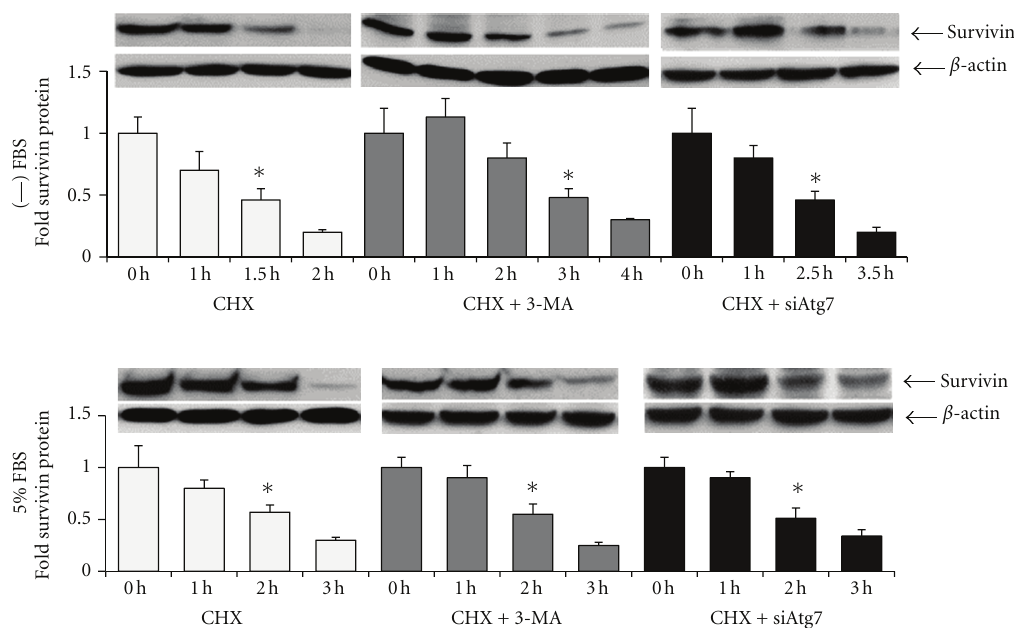
Figure 5: Survivin protein stability is increased in the presence of autophagy inhibitors in serum-free media, but not in serum-containing media. Western blots and protein quantitation graphs showing survivin protein levels over time after addition of CHX (100 μ M) to media. One representative western blot out of three repeat experiments was shown for each treatment and condition. The prominent band shown is survivin while the smaller bands are nonspecific, as determined via control experiments utilizing a neutralizing peptide for the survivin antibody. ∗ Indicates the time at which survivin protein is half of the amount at 0 hours (half-life), P < 0 .